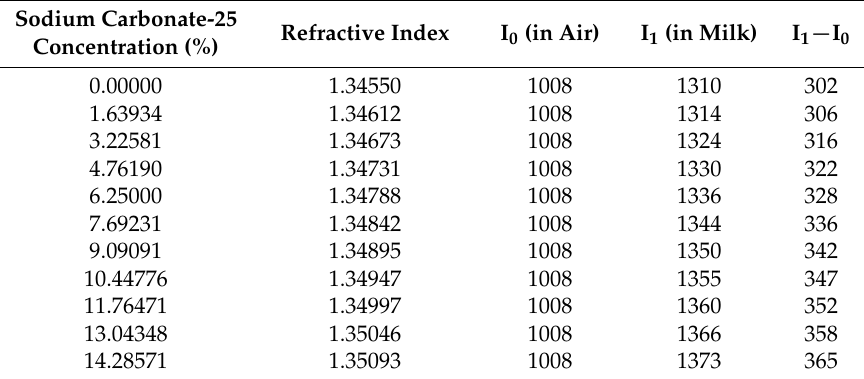
Table 6. Sensor readouts with probe P-233 for sodium